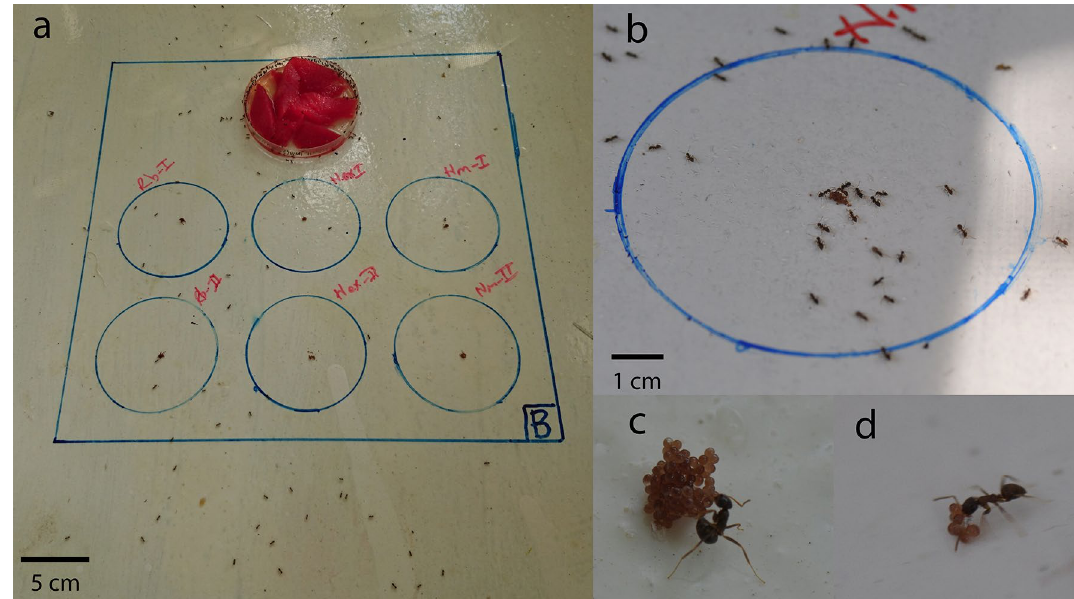
Figure 2. Experimental design in the cages. ( a ) Main square and egg-contained circles drawn on the base of cages, ( b ) an egg-contained circle attacked by the ants, ( c ) an ant exhibiting the behavior of formic acid spraying on the eggs, and ( d ) an ant carrying the tick